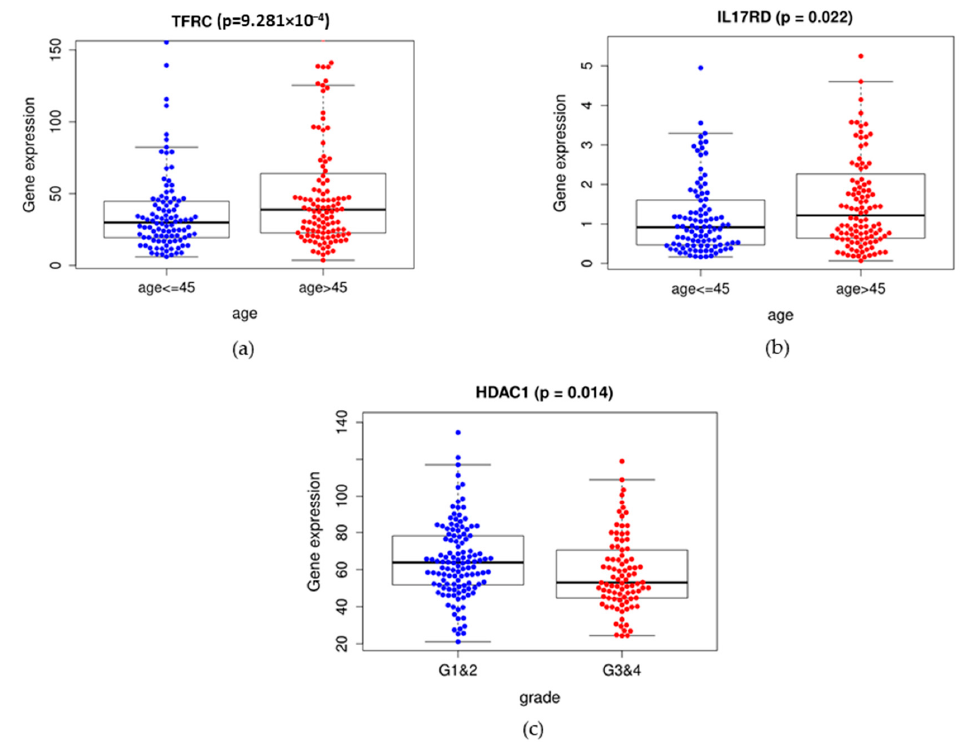
Figure 4. The clinical significance of IIRGs. The box plots showed that the expressions of TFRC, IL17RD, and HDAC1 were significantly different in subgroups of age and grade. ( a , b ) Blue represents the group of age ≤ 45years, and red represents the group of age > 45 years. ( c ) Blue represents the group of grades 1 and 2, and red represents the group of grades 3 and 4.